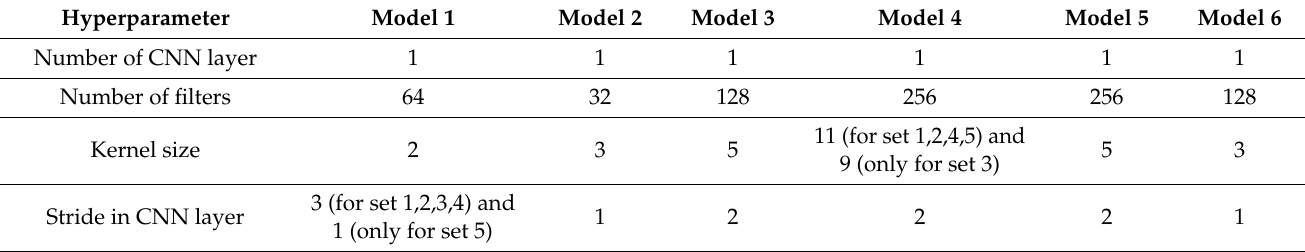
Table 4. Hyperparameter configuration for six